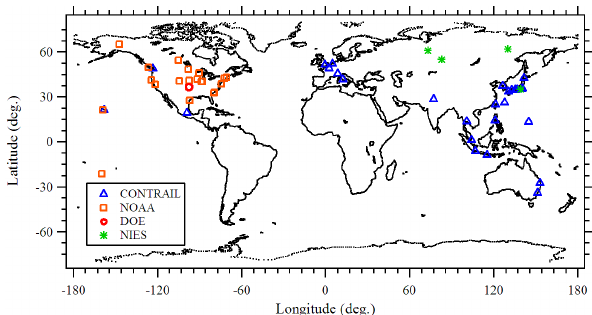
Figure 1. Observation sites used in this study. Open triangles, open squares, an Fig. 1. Observation sites used in this study. Open triangles, open open circle, and asterisks indicate CONTRAIL, NOAA, DOE, and NIES sites, squares, an open circle, and asterisks indicate CONTRAIL, NOAA, respectively. DOE, and NIES sites,